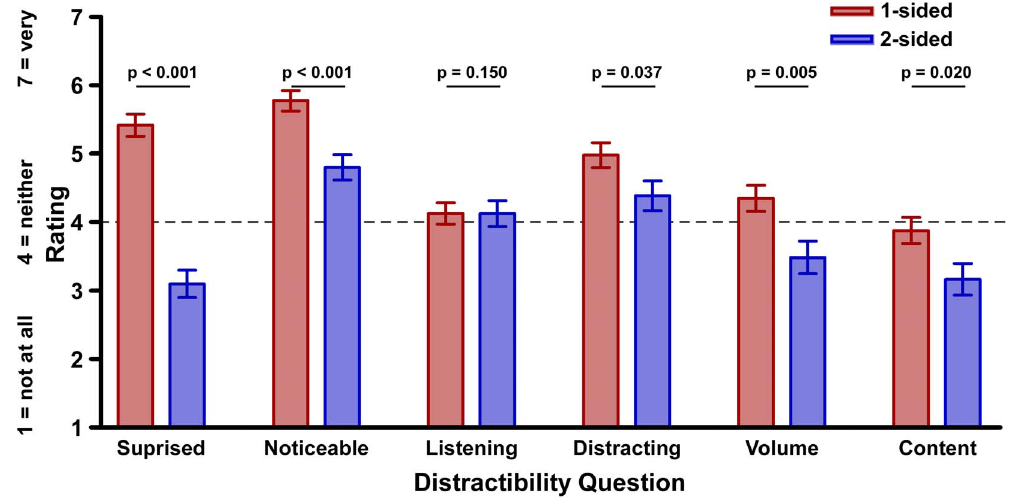
Figure 1. Average responses to distractibility scale. Participants’ averaged responses to statements on the distractibility scale. For example, responses to the statement ‘‘While the conversation was taking place, the conversation was noticeable’’ could range from 1, ‘‘not at all noticeable,’’ to